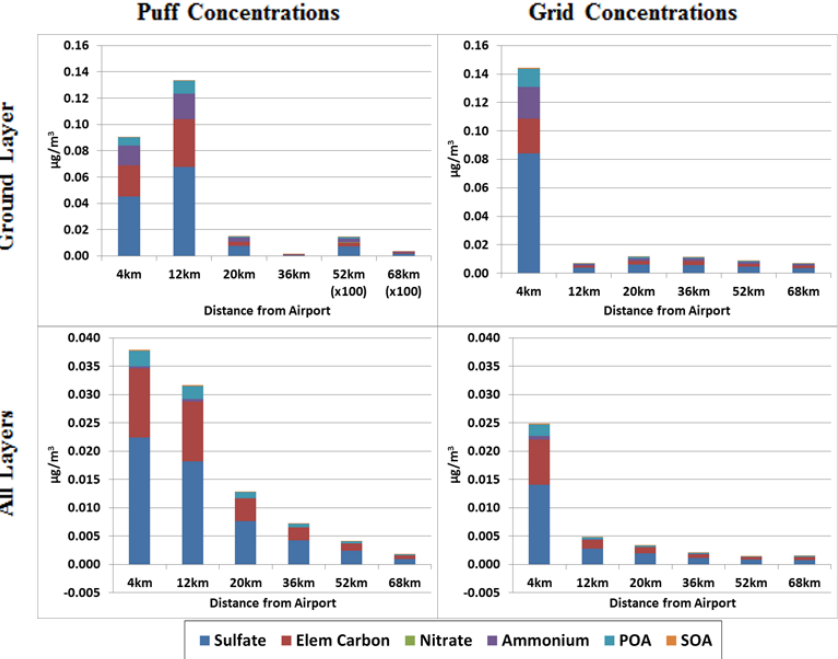
Fig. 7. Median hourly concentration of PM 2 . 5 component species (during June–July 2002) in puffs and in aircraft contribution to grid cells at various distances in the surface layer and in all layers. The analysis includes only those grid cells in the outermost ring as we go outward from the airport, and thus no overlap of grid cells in each bar. Note that the vertical axis scale varies by